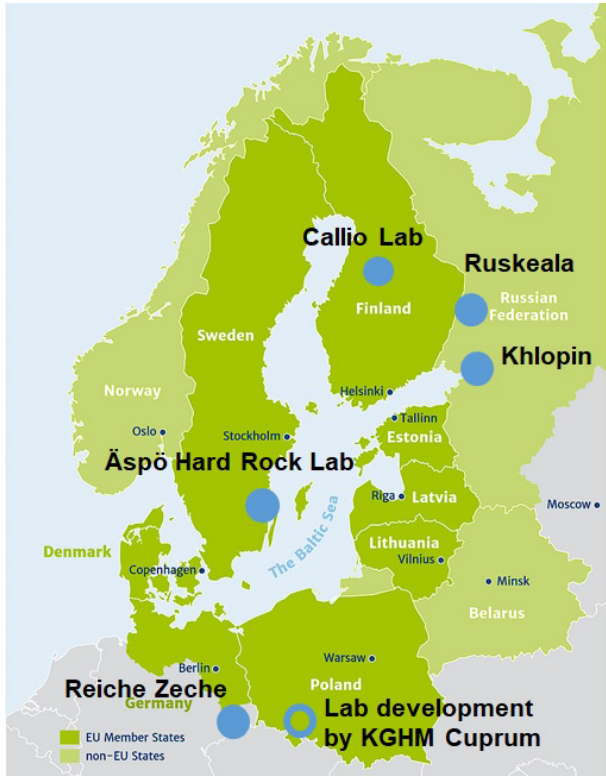
Figure 1. The map of the Baltic Sea Region showing the partner underground laboratories involved in the BSUIN and EUL projects (BSUIN,